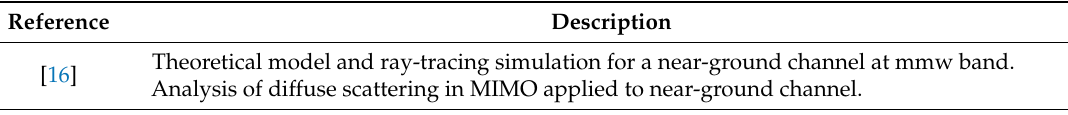
Table 3. Description of models and experimental results reported for near-ground radio channels.